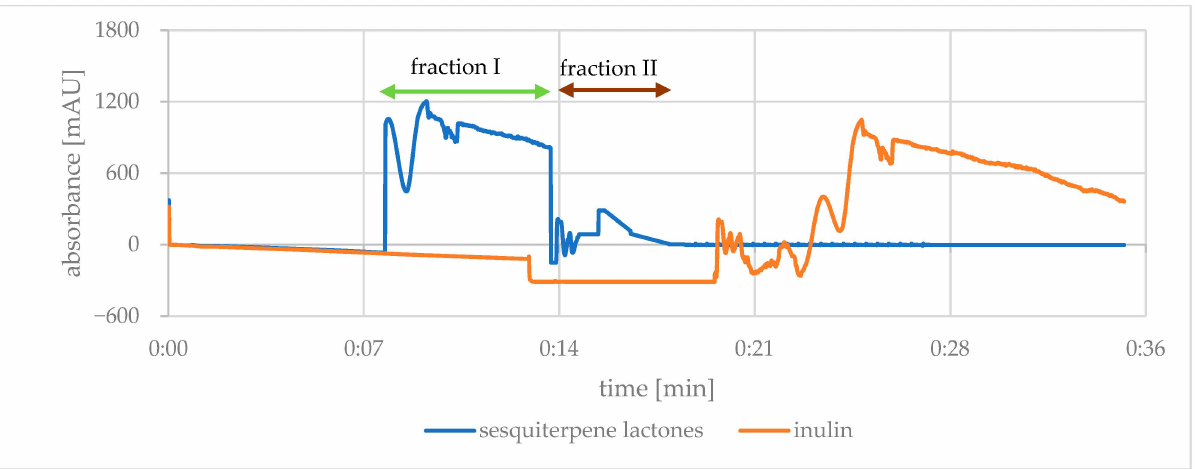
Figure 1. CPC (countercurrent partition chromatography) chromatogram of the separation of Cicho- rium intybus extract, sample 2 g/25 mL of solvent system: n-hexane:ethyl acetate:methanol:water (7:3:5:5, v / v / v / v ); flow rate: 30 mL/min, rotation speed: 500 rpm; detection wavelength: 254 nm (sesquiterpene lactones), 285 nm